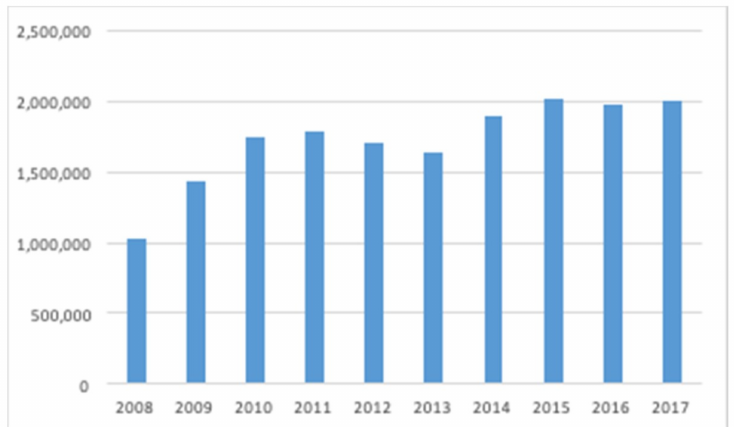
Figure 3. Annual tourist